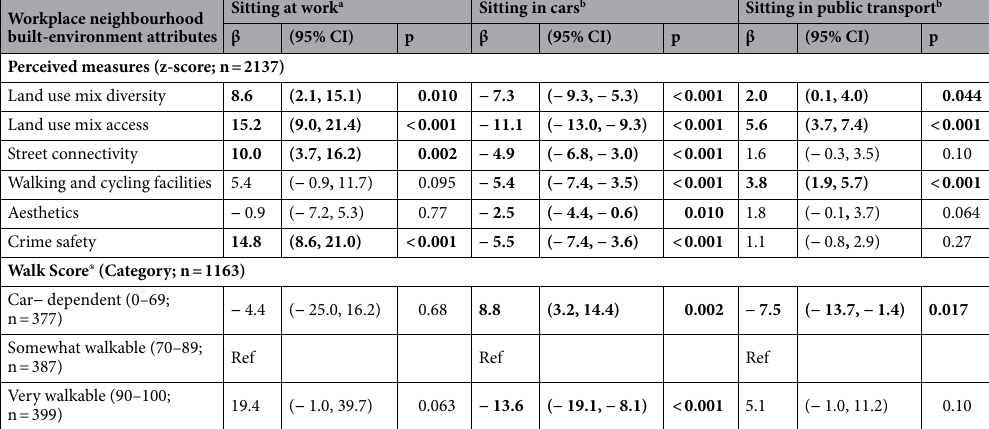
Table 3. Associations of sitting time at work, in cars, and in public transport with workplace neighbourhood built-environment attributes. β unstandardised regression coefficient (minutes/day) corresponding to 1 SD increment in perceived attributes and relative to the workplaces located in somewhat walkable neighbourhoods, CI confidence interval. a Models were adjusted for gender, age group, marital status, educational level, individual annual income, physical activity duration, work hours per week, and workplace size. b Models were adjusted for gender, age group, marital status, educational level, individual annual income, physical activity duration, driving licence, work hours per week, and workplace size. Figures highlighted in bold indicate statistically significant findings (p <